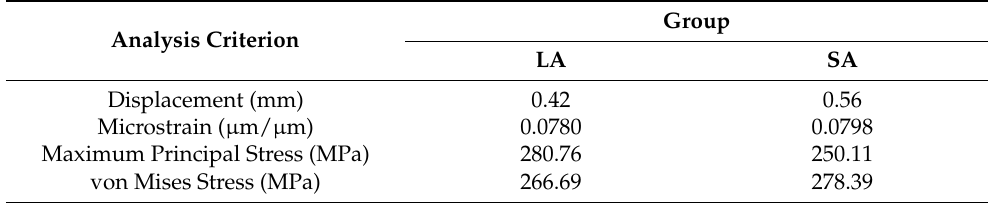
Table 4. Quantitative analysis of von Mises stress results in stress peaks (MPa) in the structures and bone microstrains ( µε ) of each